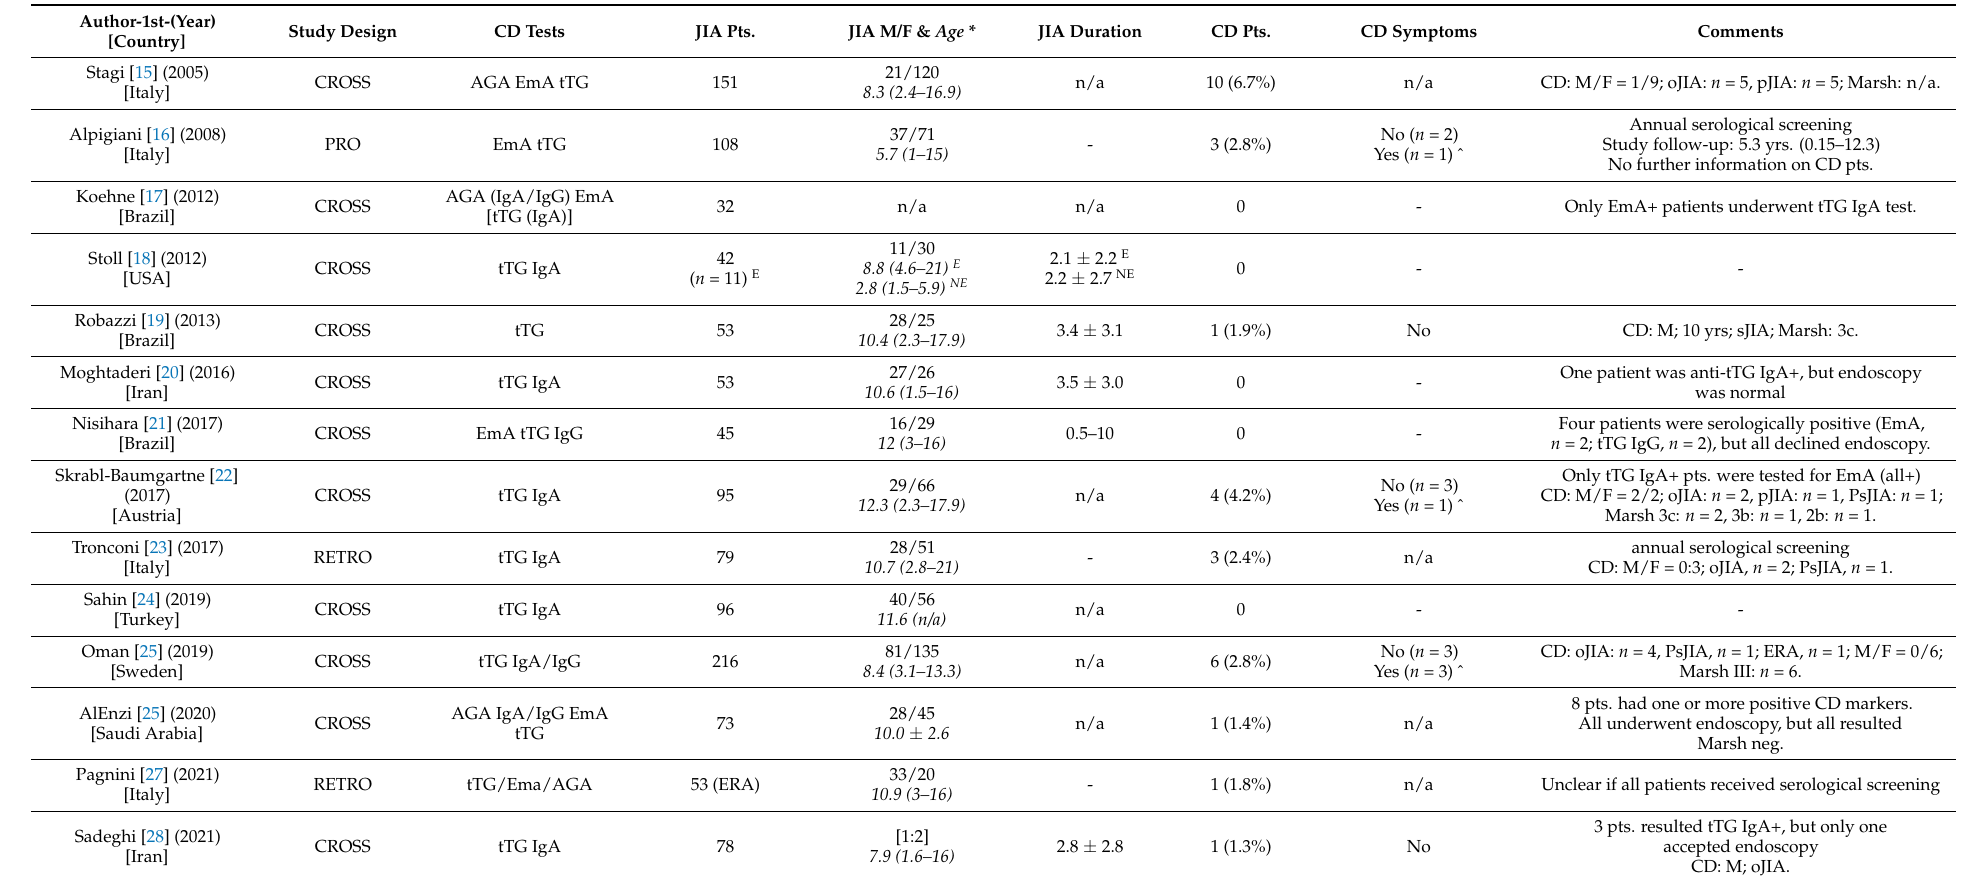
Table 1. Clinical studies assessing CD in children affected with